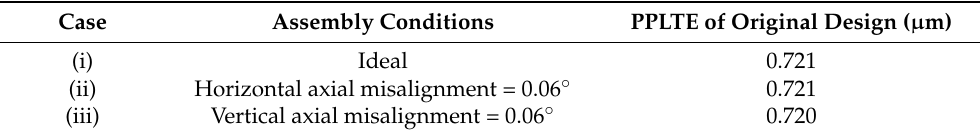
Table 3. PPLTEs of the original design with various assembly conditions.